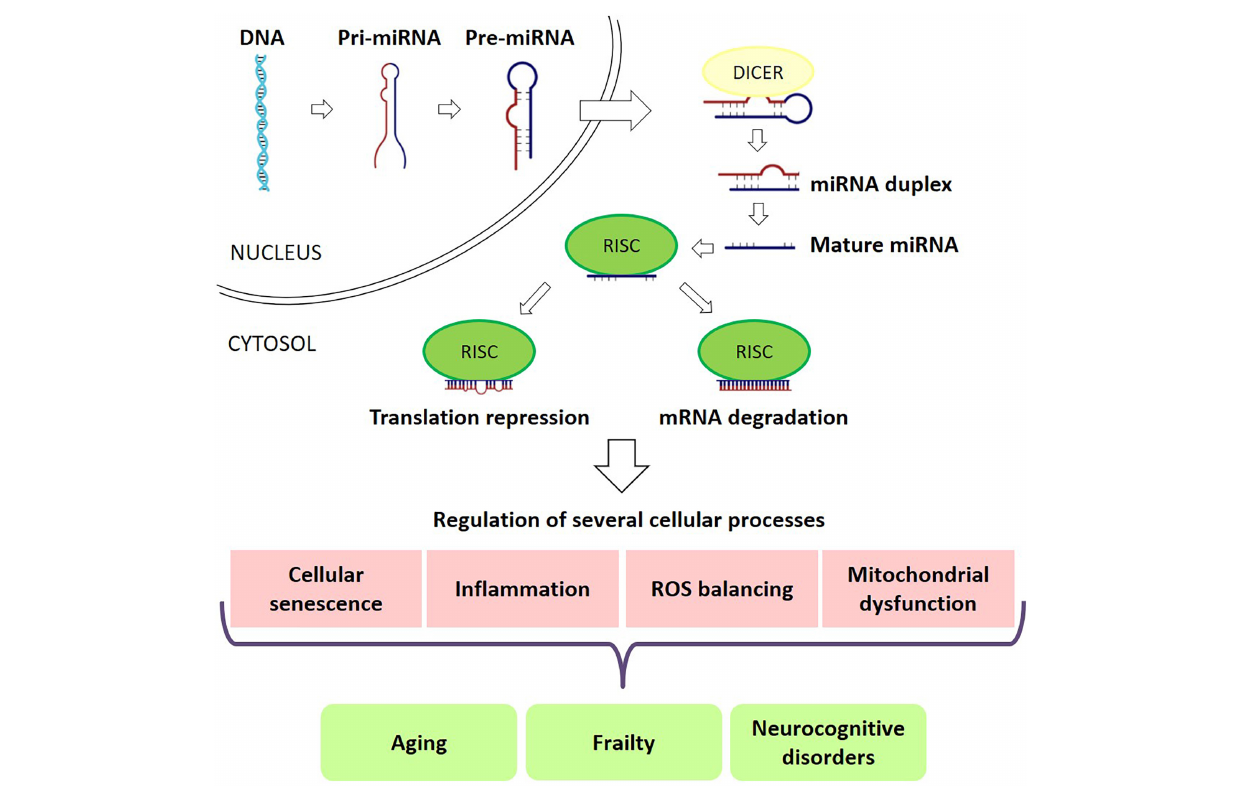
FIGURE 1 | miRNAs in frailty and cognitive deficits. miRNAs play a major role in RNA silencing and post-transcriptional regulation of gene expression. miRNAs target hundreds of transcripts to regulate various biological pathways and processes, repressing translation or inducing mRNA degradation of target transcripts through sequence-specific binding. miRNAs are key modulators of almost all physiological processes and, consequently, miRNA dysregulation is seen in a multiplicity of diseases, including frailty and cognitive